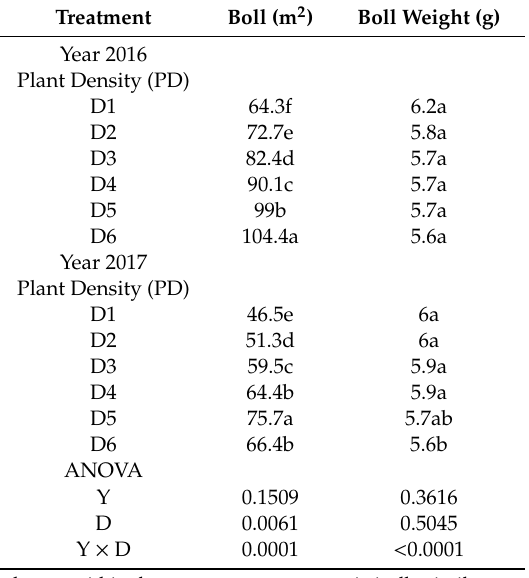
Table 1. Comparison of boll m − 2 and boll weight (g) at various plant densities in 2016 and 2017 in the cotton growing season.